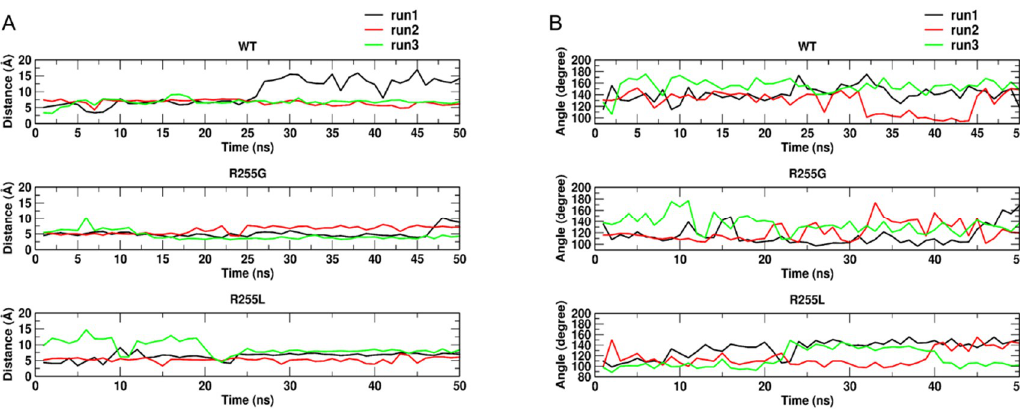
Figure 9. ( A ) Calculated distance between C5-atom of substrate and iron-bound oxygen species. ( B ) Calculated angle between benzo-1,4-dioxane substrate and heme required for the hydroxylation of benzo-1,4-dioxane in WT and variants R255G and R255L along three independent 50 ns molecular dynamics (MD) simulation trajectories.